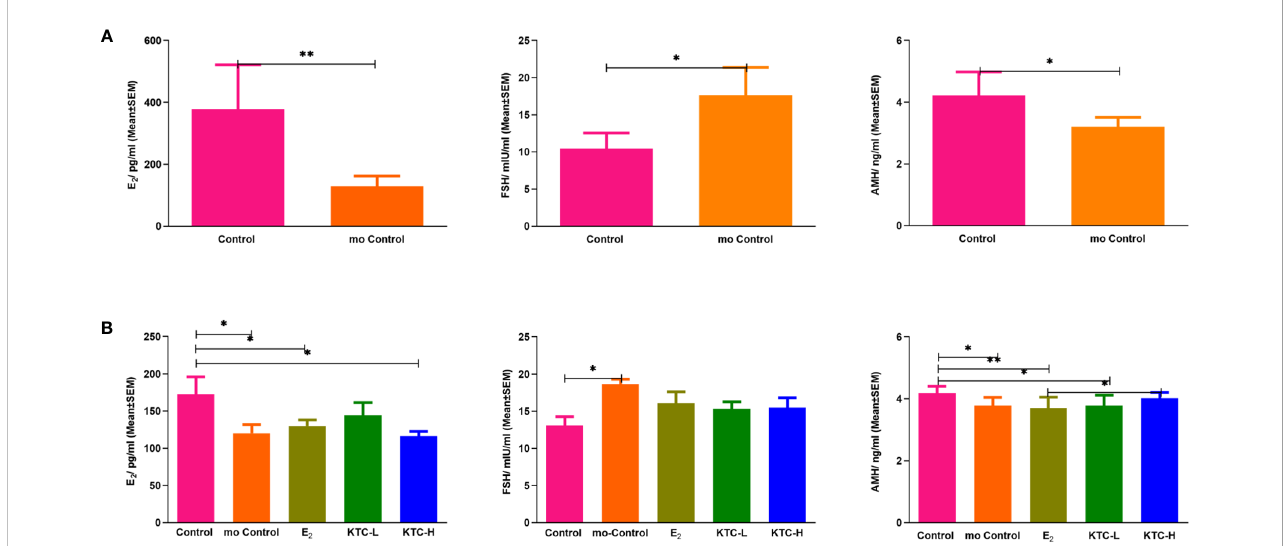
FIGURE 3 (A) Serum E 2 , FSH, and AMH levels after establishing the POI model. * P <0.05; ** P <0.01 (B) Serum E 2 , FSH, and AMH levels in the fi ve groups after administration for 28 days. * P <0.05; ** P <0.01.